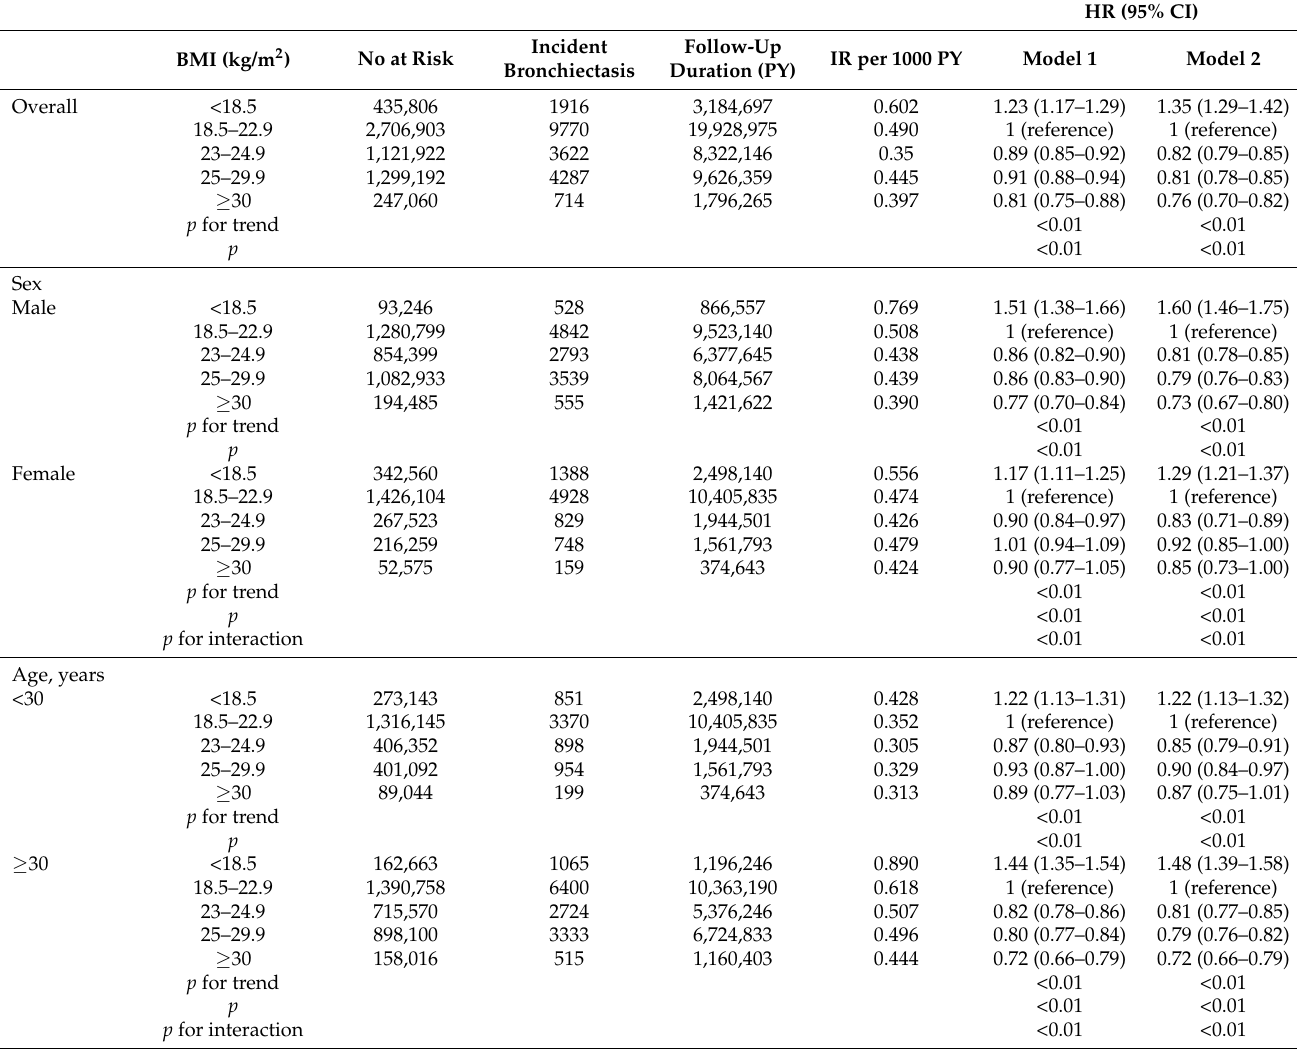
Table 3. Subgroup analysis of the risk of bronchiectasis according to BMI